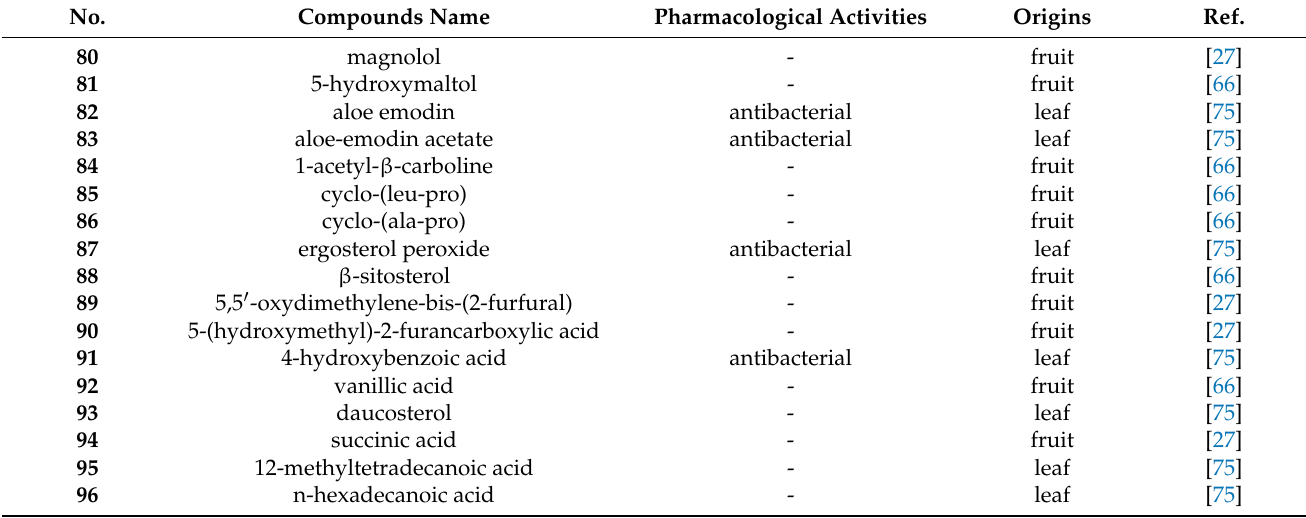
Figure 5. The structures of flavonoids from S. grosvenorii . Table 3. Other compounds isolated from S. grosvenorii